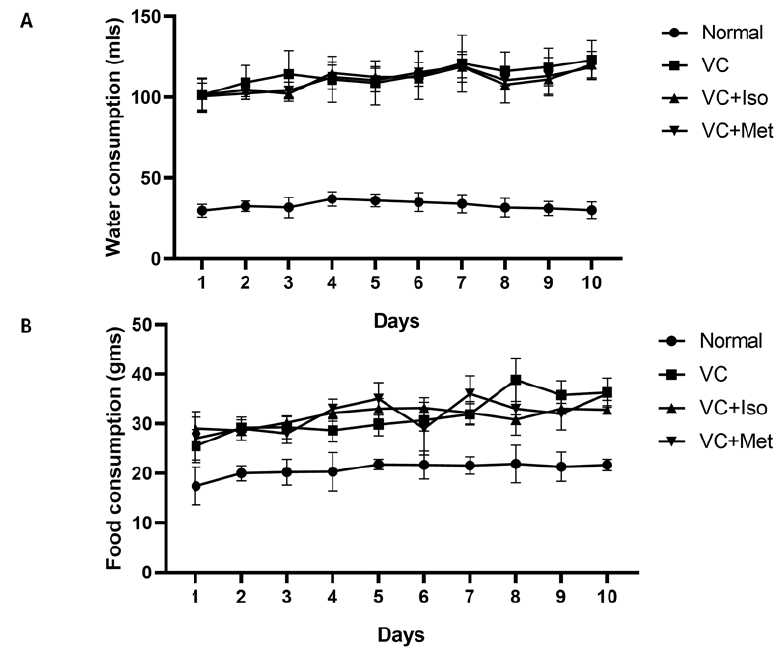
Figure 3. Water and food consumption was higher in diabetic groups. Water consumption ( A ) was significantly higher in diabetic groups compared to non-diabetic group. Food consumption ( B ) was higher in diabetic groups compared to non-diabetic group. Two-way ANOVA followed by Tukey post hoc. VC; vehicle control, Iso; isorhamnetin, Met; metformin.